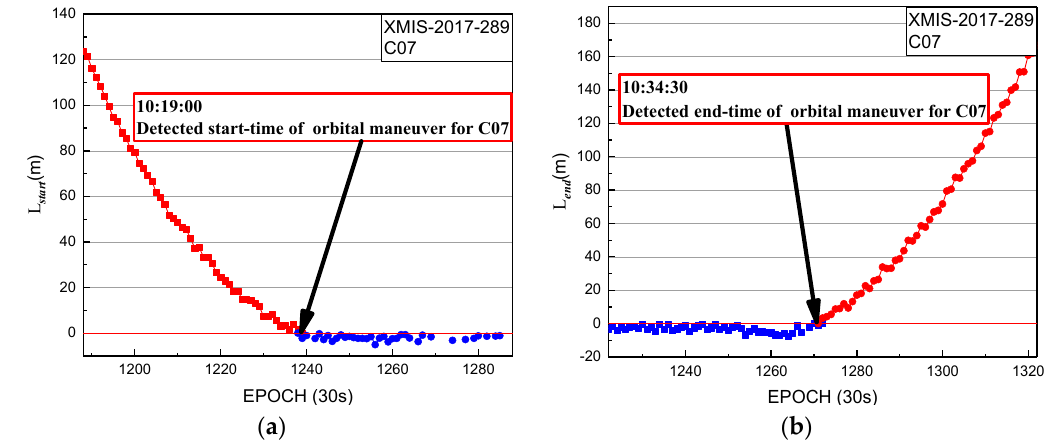
Figure 11. Detection results of XMIS station for C07 on 16 October 2017; ( a ) start time factor of XMIS station for C07 on 16 October 2017; ( b ) end time factor of XMIS station for C07 on 16 October 2017.